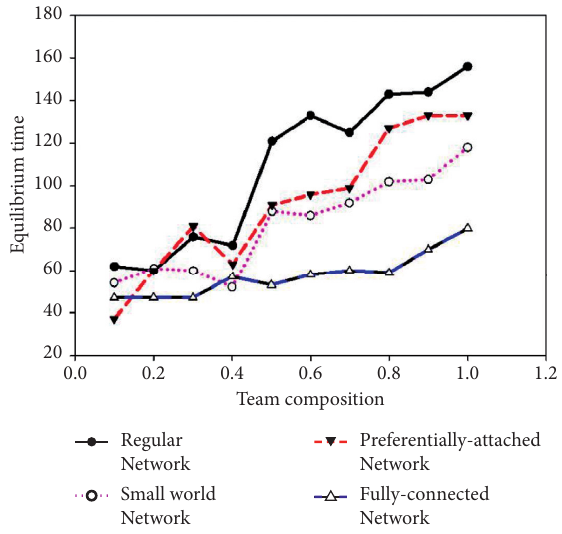
Figure 7: Equilibrium time among different team compositions.